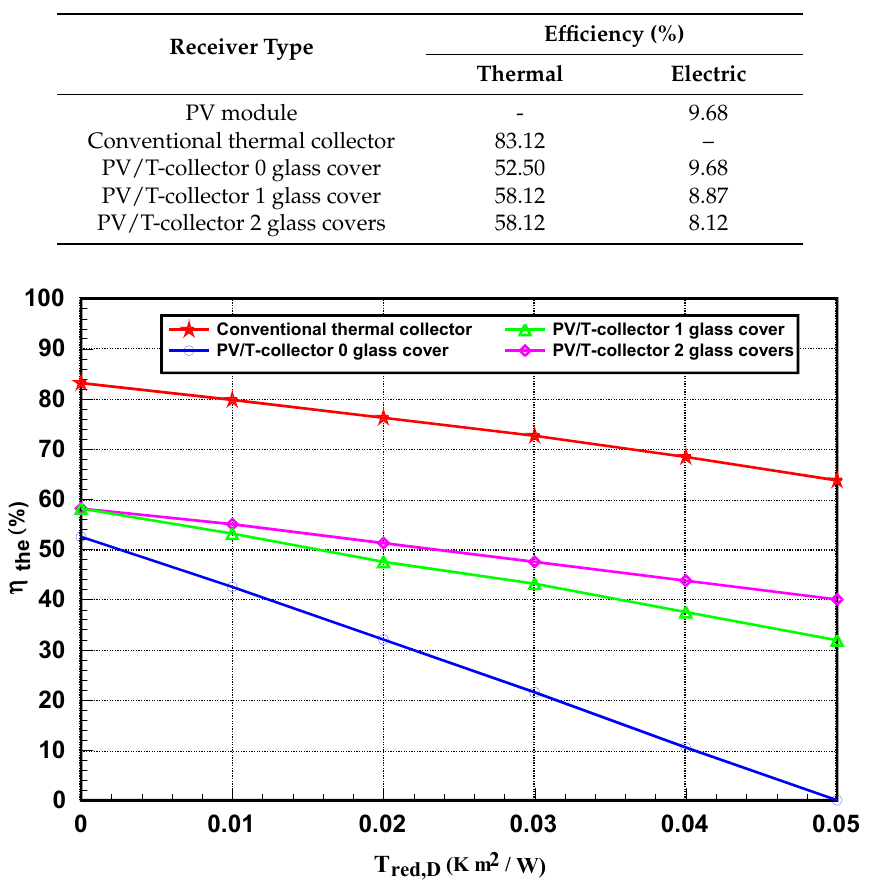
Figure 11. Thermal efficiency against reduced temperature for various designs.